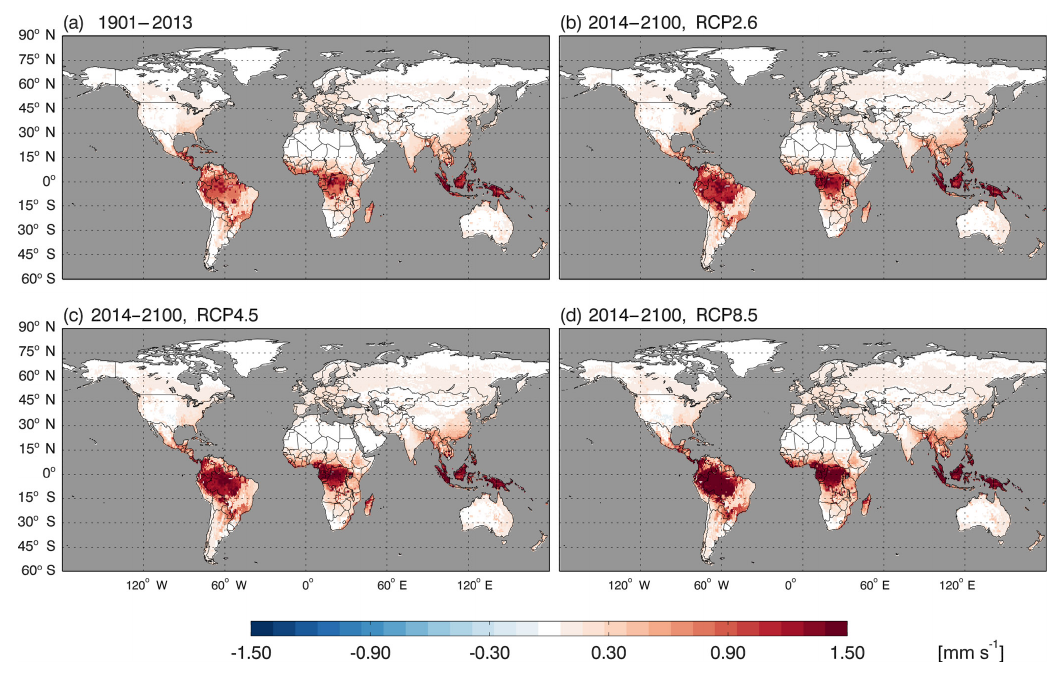
Figure 10. Global annual mean CO deposition velocity using constant in time and spatially distributed CO concentration data (mms − 1 ) (a) during 1901–2013 and (b) , (c) , (d) under the future climate scenarios RCP2.6, RCP4.5 and RCP8.5 during 2014–2100, respectively. Table 5. Sensitivity of the global CO consumption, net flux and production (TgCOyr − 1 ) to the changes in atmospheric CO, soil organic carbon (SOC), precipitation (Prec) and air temperature